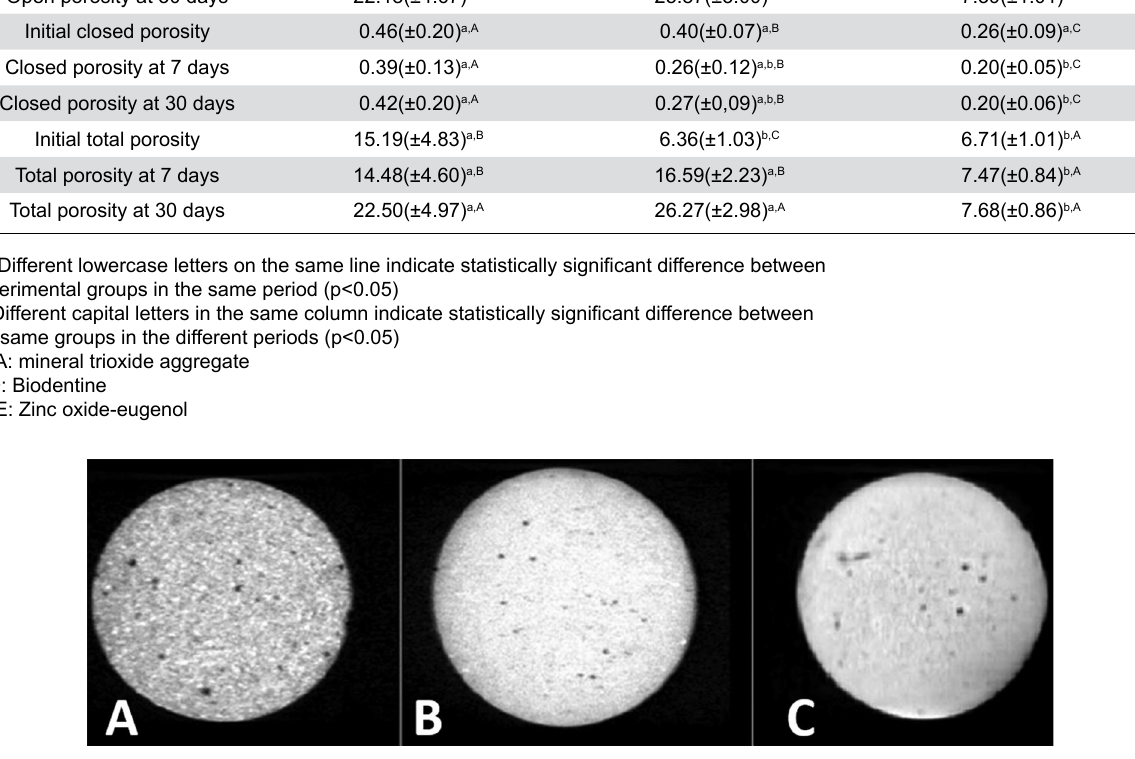
Figure 3- Microtomographic images captured with the CTAn program, representative of the porosity for (A) White mineral trioxide aggregate (MTA) Angelus, (B) Biodentine (BIO), and (C) Zinc oxide-eugenol (ZOE) cements at the initial period